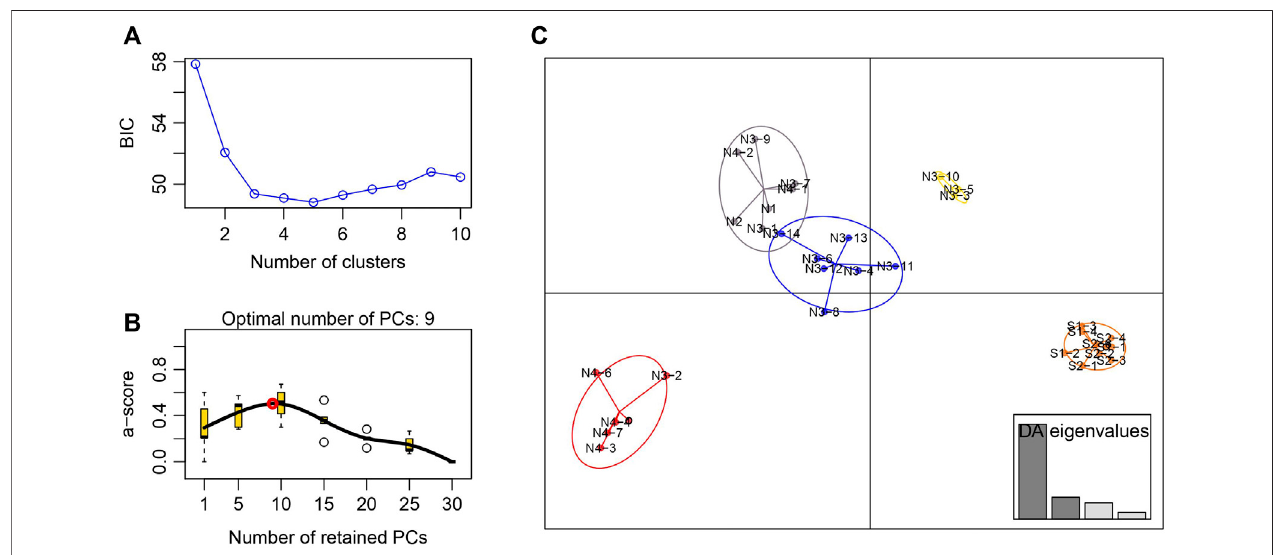
FIGURE 4 | Discriminant analysis of principal components of the microsatellite data for Xanthocyparis vietnamensis populations from Guangxi, China (A) Value of BIC versus number of clusters (B) A-score optimisation — spline interpolation (C) Scatter plots of the discriminant analysis of principal components. Each circle represents a cluster and each dot represents an individuals. DAPC assignment plot based on four discriminant functions. Eigenvalues are displayed in inset.